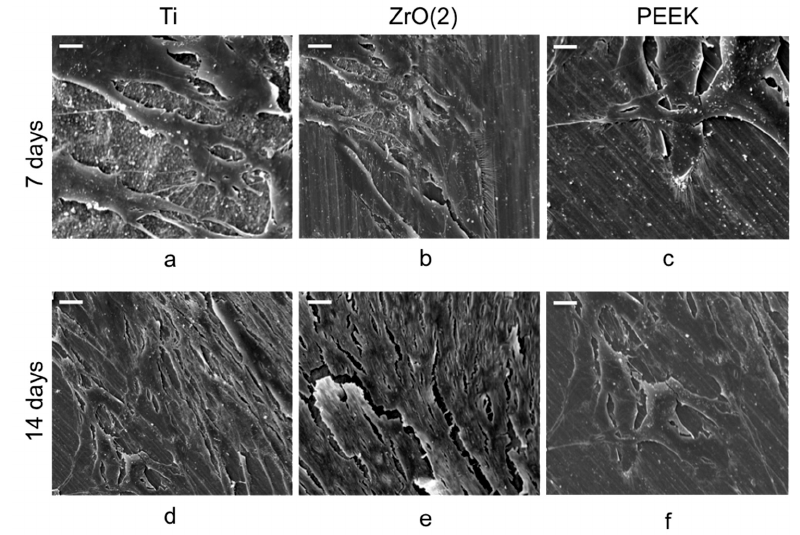
Figure 2. Images of SEM (1k× magnification) obtained from HGEK grown on the disks (confluence reached after seven days) ( a – c ). Monolayer formation was found to be continuous up up to 14 days ( d – f ). Scale Bar = 10 μ